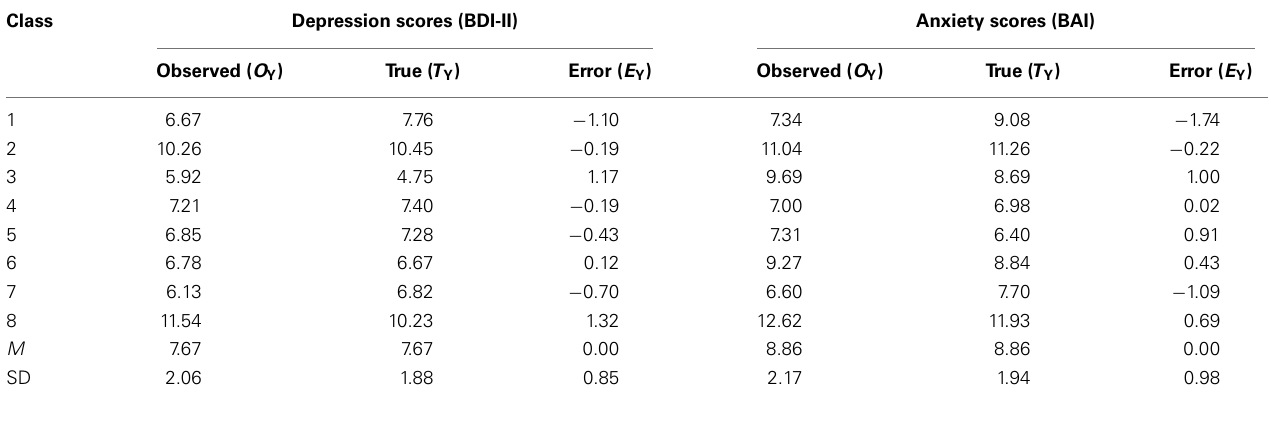
Table 3 | Beck data observed, error, and true scores.